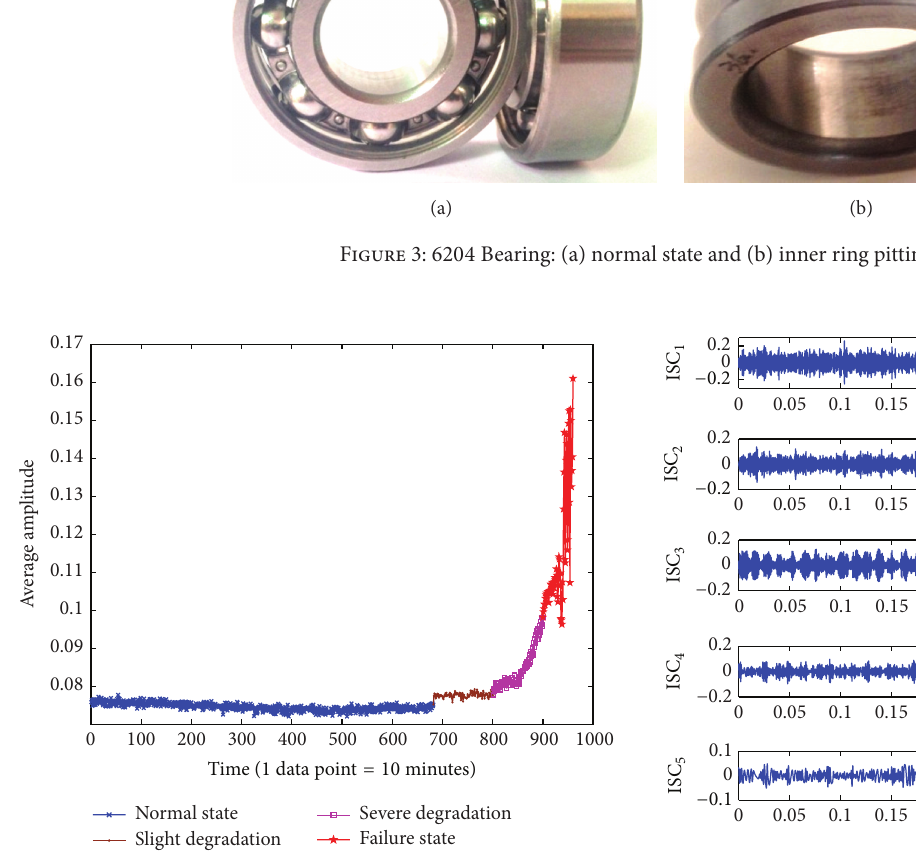
Figure 4: The preliminary division of degradation state based on average amplitude.